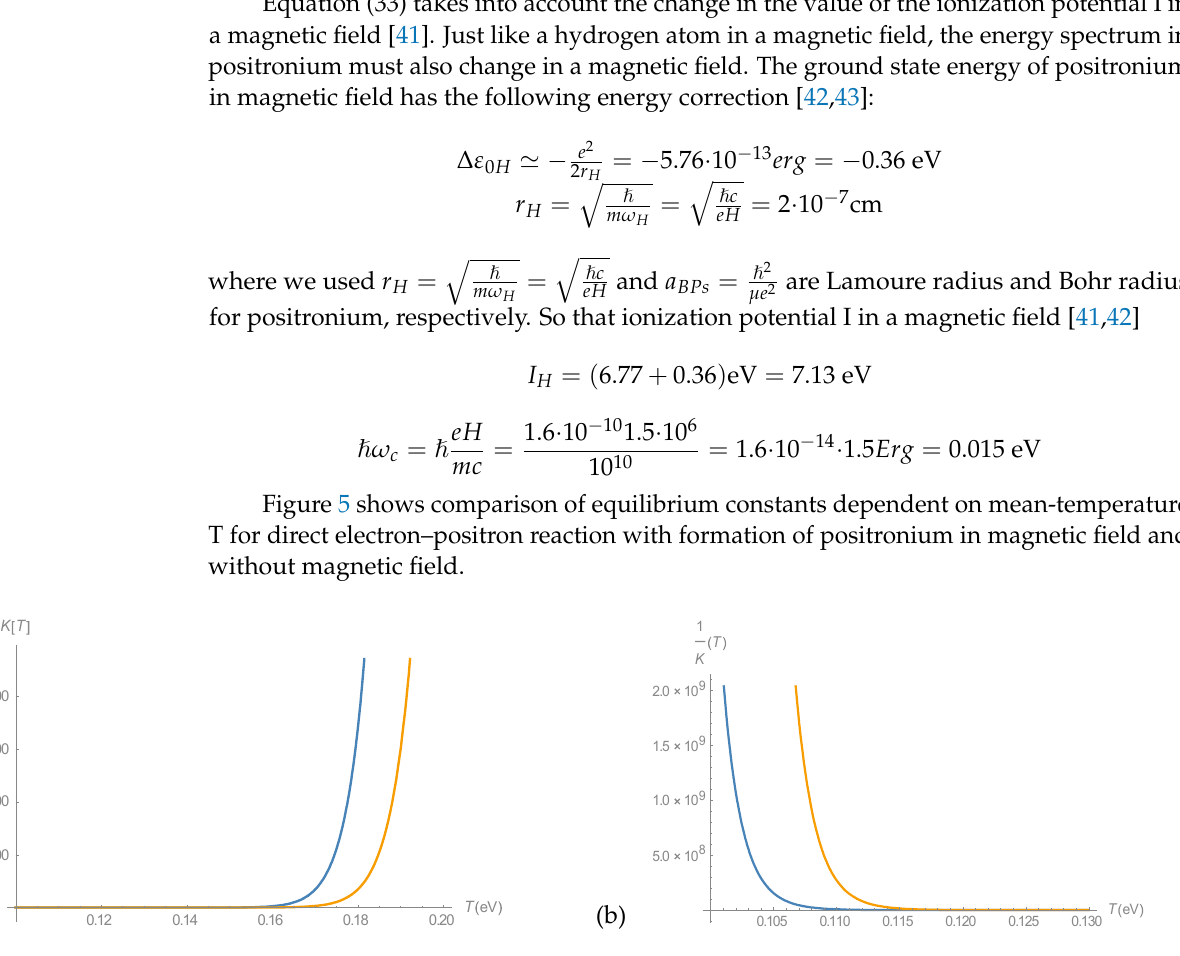
Figure 5. A dependence of equilibrium constant on mean-temperature T for direct electron–positron reaction with formation of positronium in magnetic field (yellow line) and without magnetic field (blue line) ( a ) K(T); ( b ) A reverse constant 1/K in a magnetic field (yellow line) and without magnetic field (blue line).